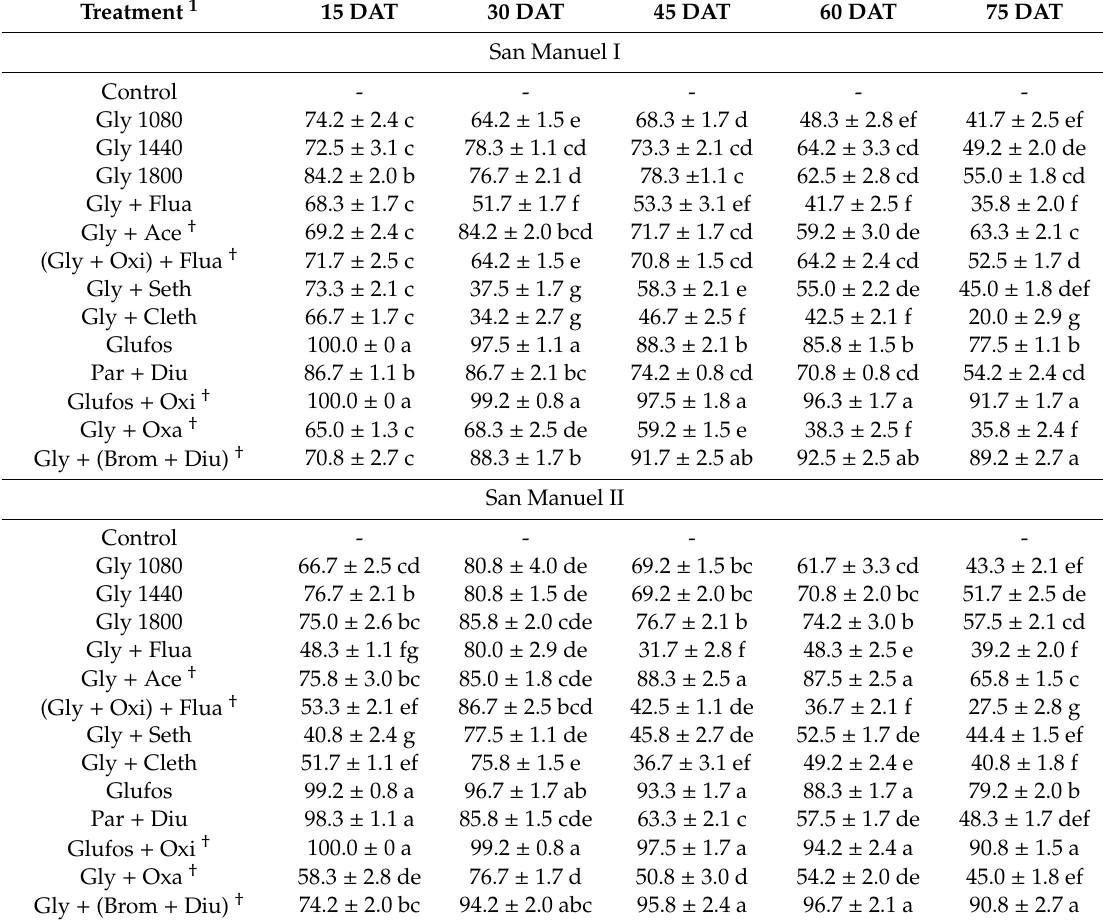
Table 3. Total weed control percentage with pre- and post-emergence herbicides in two Persian lime groves of the “San Manuel” Farm, Puebla, Mexico from 15 to 75 days after treatment (DAT). Visual control was measured as 0 = no control and 100 = plant